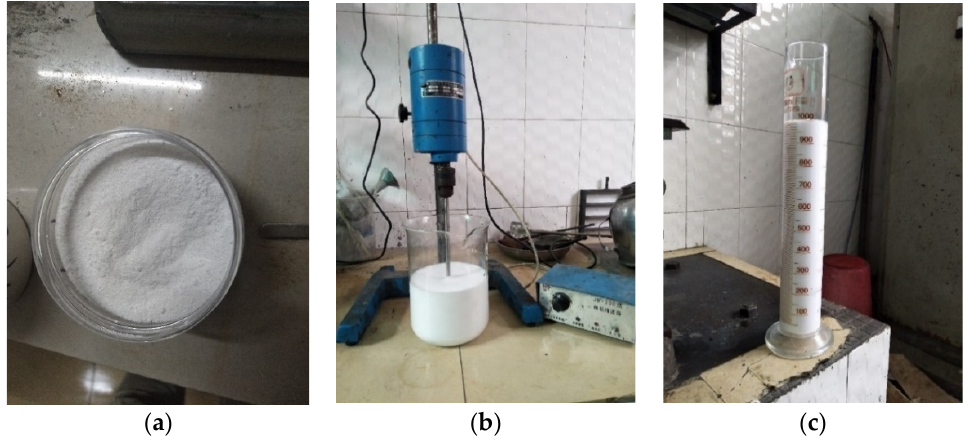
Figure 1. Manufacturing procedure of foam: ( a ) foaming agent; ( b ) stirring fully; ( c ) reading the foam volume.